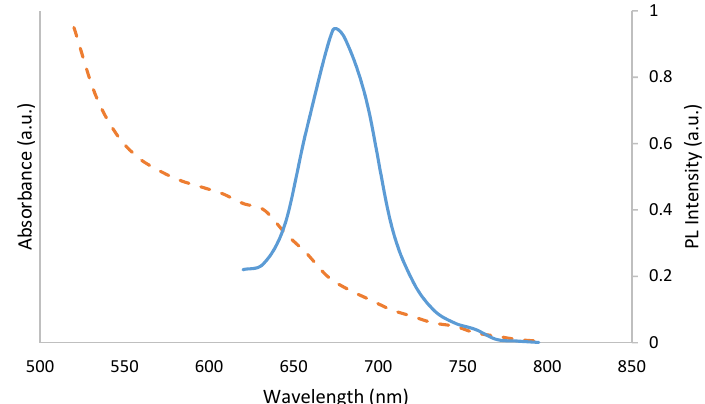
Fig. 8. a: Fluorescence emission spectra (solid line) b: UV/Vis absorption spectra (dashed line) for as-synthesized CuInS Fig. 8.A: Fluorescence emission spectra (solid line) B: UV/Vis absorption spectra (dashed line) for as-synthesized CuInS